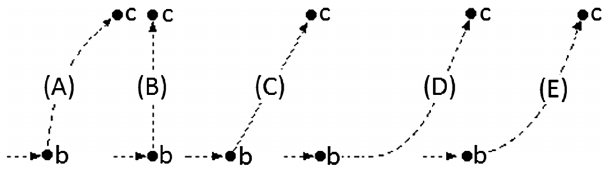
FIG. 1. Diagram for question 12 on the FCI, which provides the answer choices. FIG. 2. Answer choices provided for question 21 on the